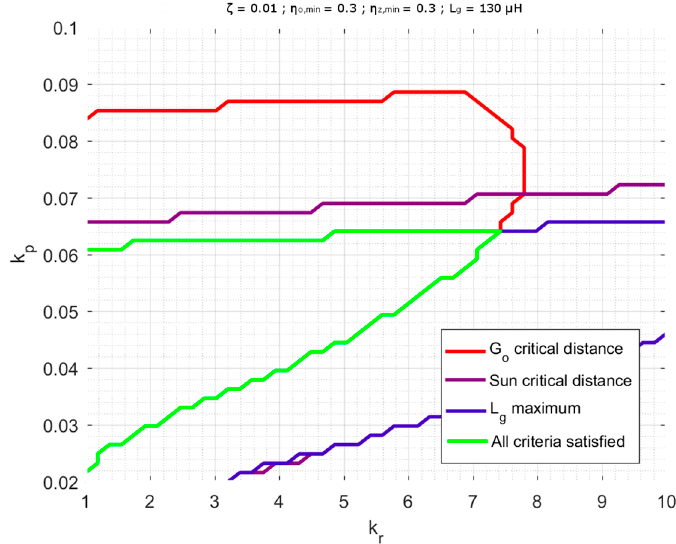
Figure 8. Optimization results of the proposed method.